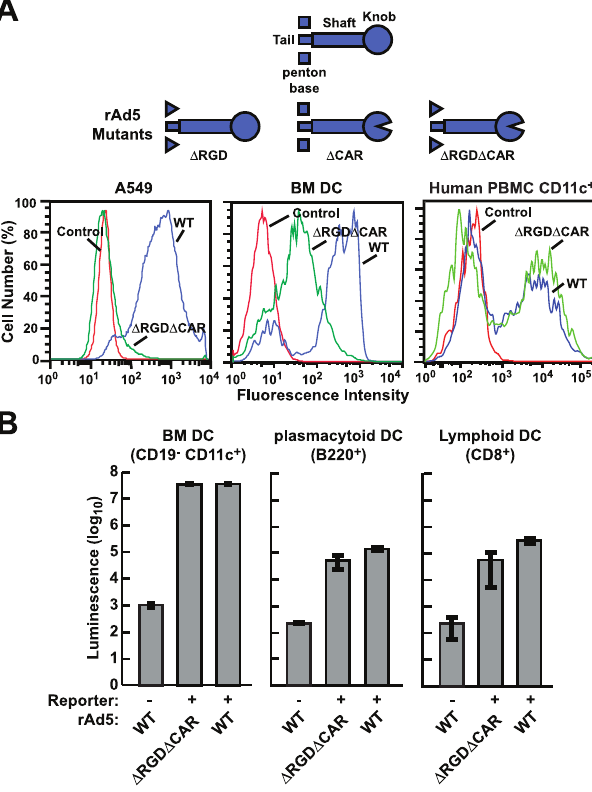
Figure 1. Specificity of WT or CAR (cid:2) RGD (cid:2) rAd Vectors for Different Cell Types: Mutant Virus Retains Ability to Infect DCs but Not Other Cell Types (A) GFP expression following transduction by rAd5 vectors with WT capsid proteins or mutated fiber and penton base proteins at 1,000 viral particles per cell. Transduction of human squamous epithelial cell A549, mouse BM-derived DCs, and human CD11c þ PBMCs was assessed by flow cytometry at 48 h post transduction. (B) Transduction by the indicated rAd vectors expressing luciferase was evaluated in mouse DCs. BM cells were isolated from BALB/c mice and cultured for 1 wk in the presence of GM-CSF [19]. The cells were transduced with indicated viruses at 3,000 viral particles per cell, and at 24 h postinfection, cells were stained with anti-CD19 and -CD11c antibodies and sorted into CD19 (cid:2) and CD11c þ cells with FACSDiVa (BD Biosciences). Mouse plasmacytoid and lymphoid DCs were isolated with magnetic cell sorting and transduced with the indicated viruses at 10,000 viral particles per cell. Luciferase expression was measured at 24 h after transduction. The average of three infections is shown, along with standard deviations.